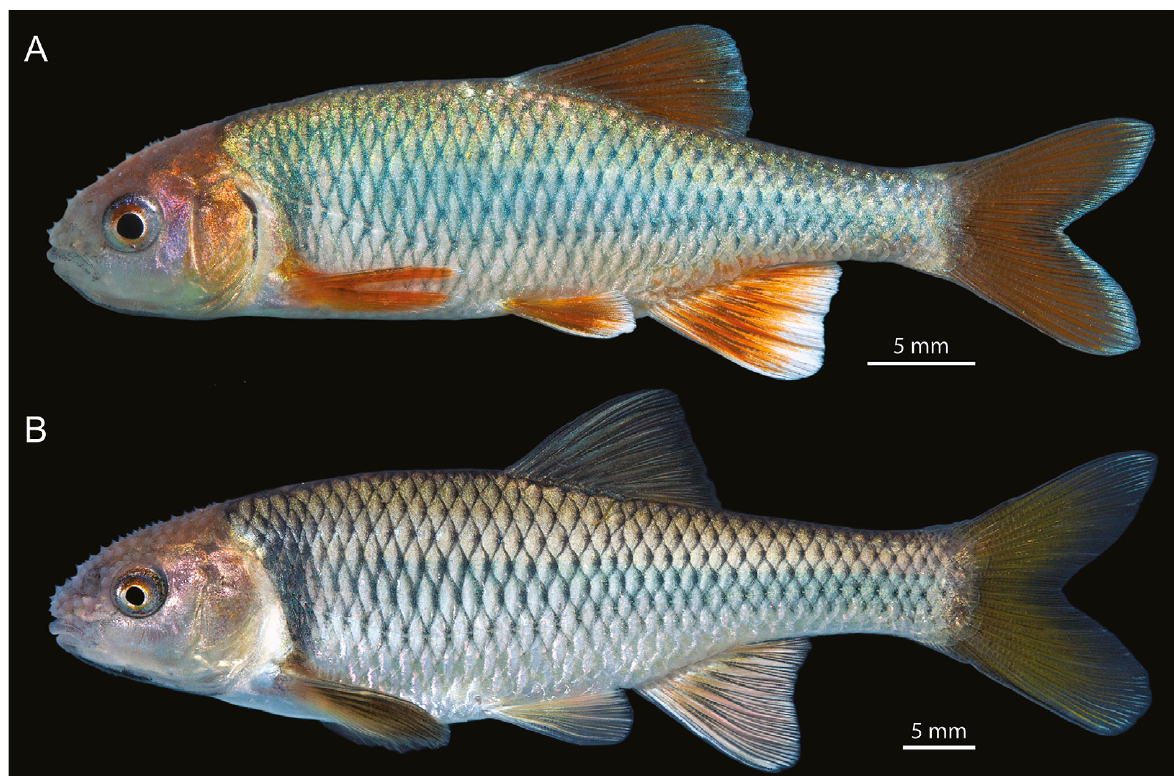
Figure 1. A. Cyprinella panarcys , TCWC 19724.01, male, 36.0 mm SL; Rio Grande, Presidio Co., Texas, USA; pectoral fin split at center. B. Cyprinella proserpina , TCWC 16885.09, male 60.0 mm SL; Independence Creek, Terrell Co., Texas,